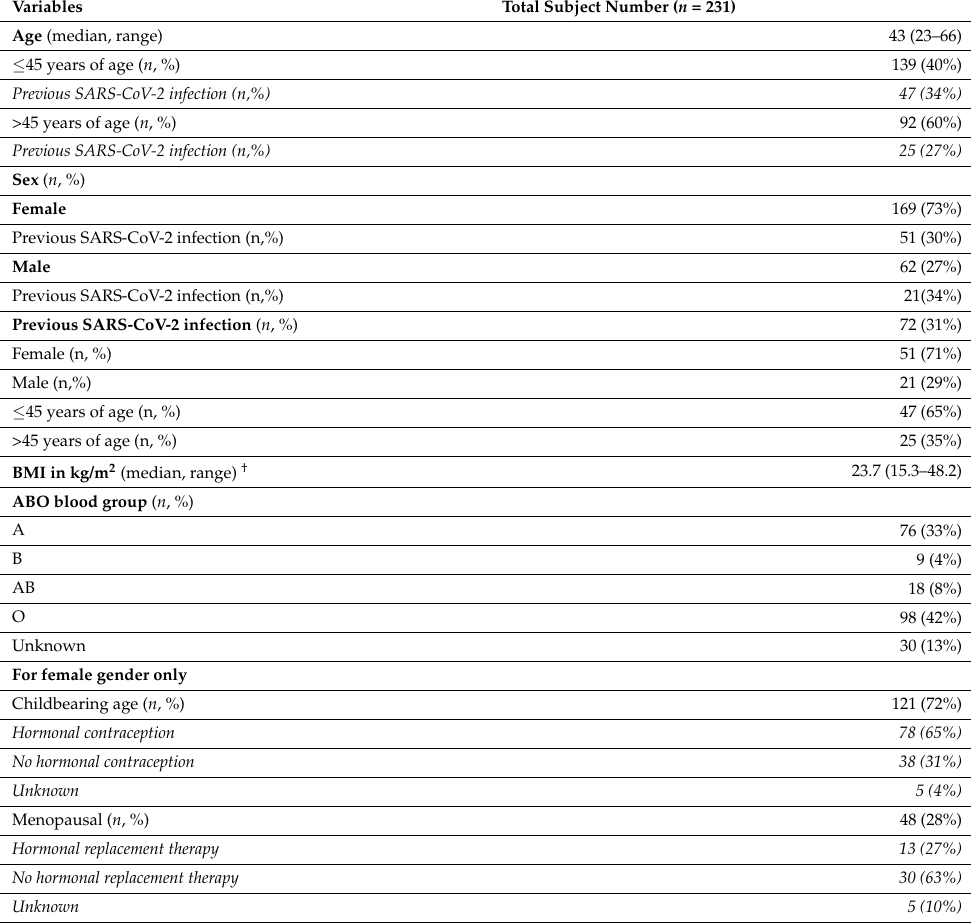
Table 1. Demographical characteristics of the